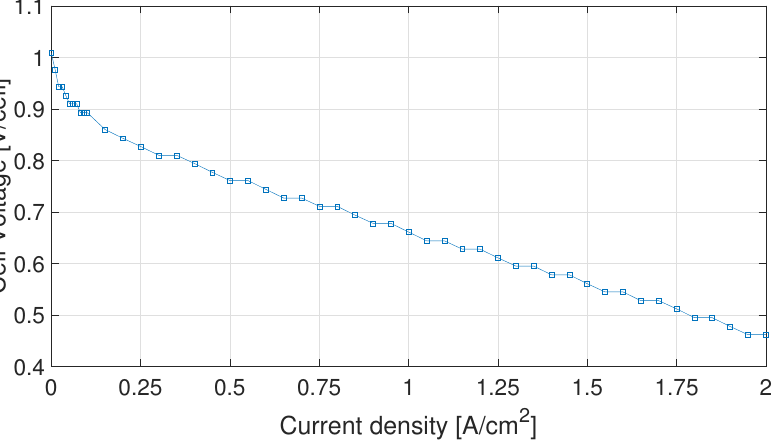
Figure 1. PEMFC polarization curve, obtained for a cell of 25cm 2 active area at CNR-ITAE laboratories. FC Equivalent Electric Circuit Model tries to represent the FC components and the polarization phenomena with circuit elements; thus, a resistor represents the ohmic loss of the membrane and the transfer resistances of each electrode [11], a rectifying diode is associated with the electrode polarization, and the load resistance can be a simple resistor or a more complex impedance, such as an inductor [28]. Other elements (inductor or Warburg element) make sense depending on the frequency range